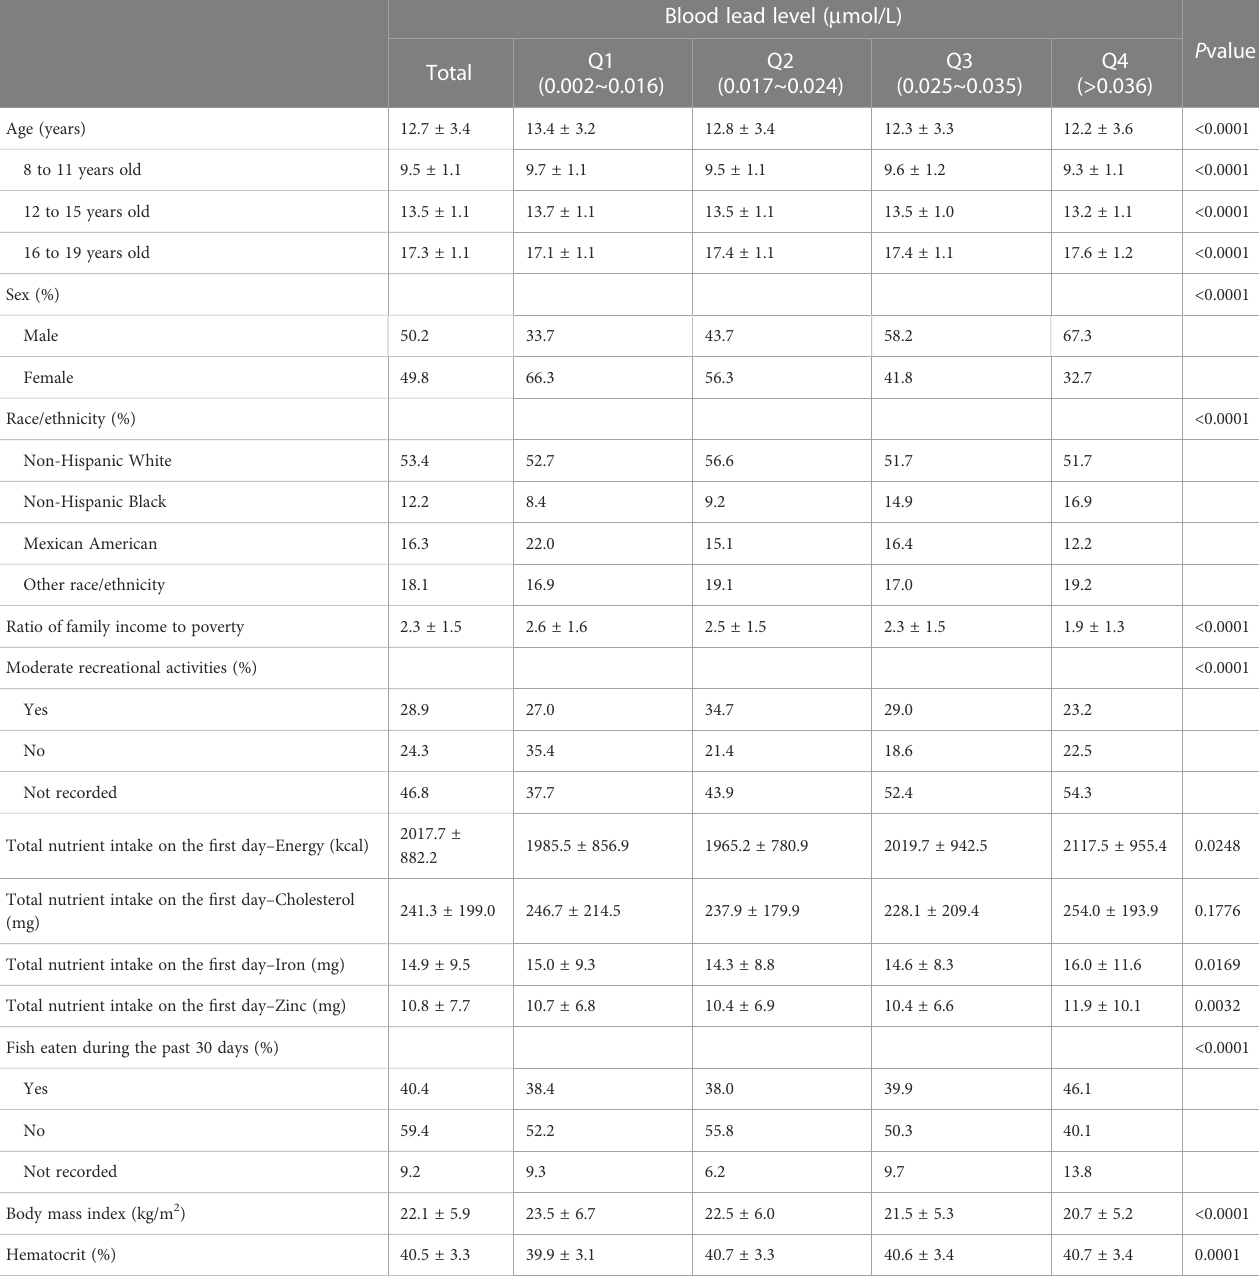
Blood lead level ( m